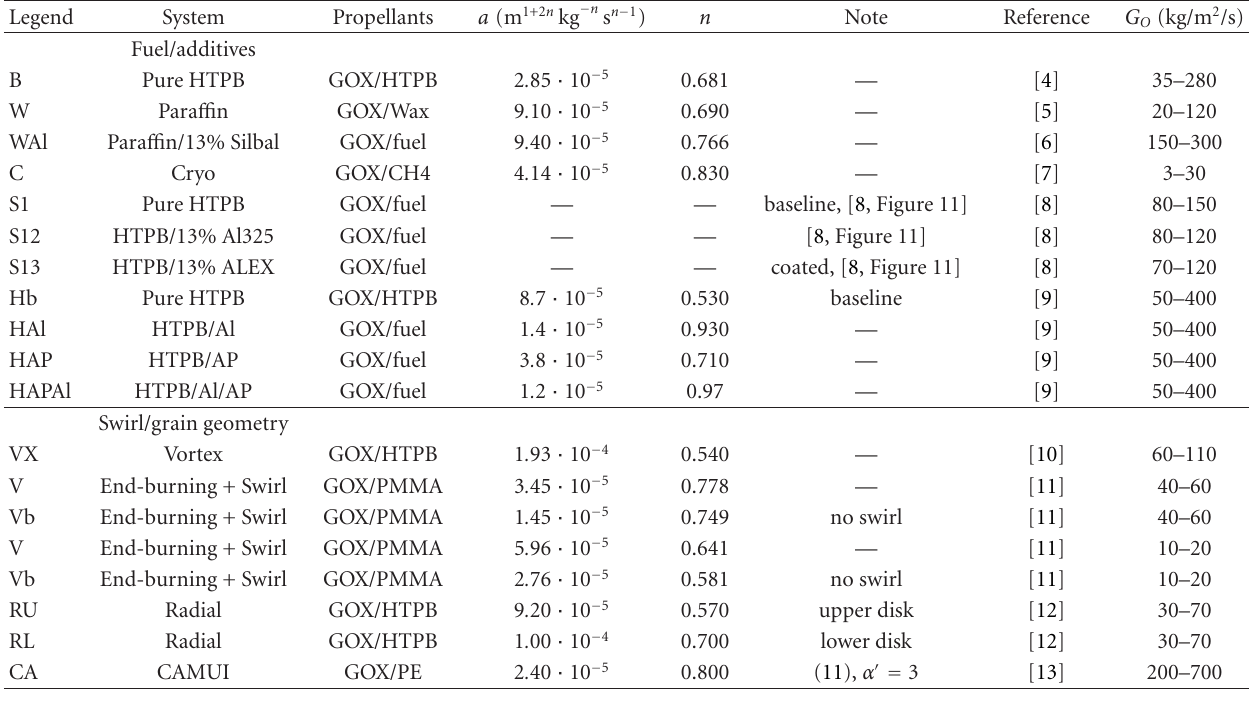
Table 1: Values of a and n to be used in (3) ( r in m/s and G O in kg/m 2 s).